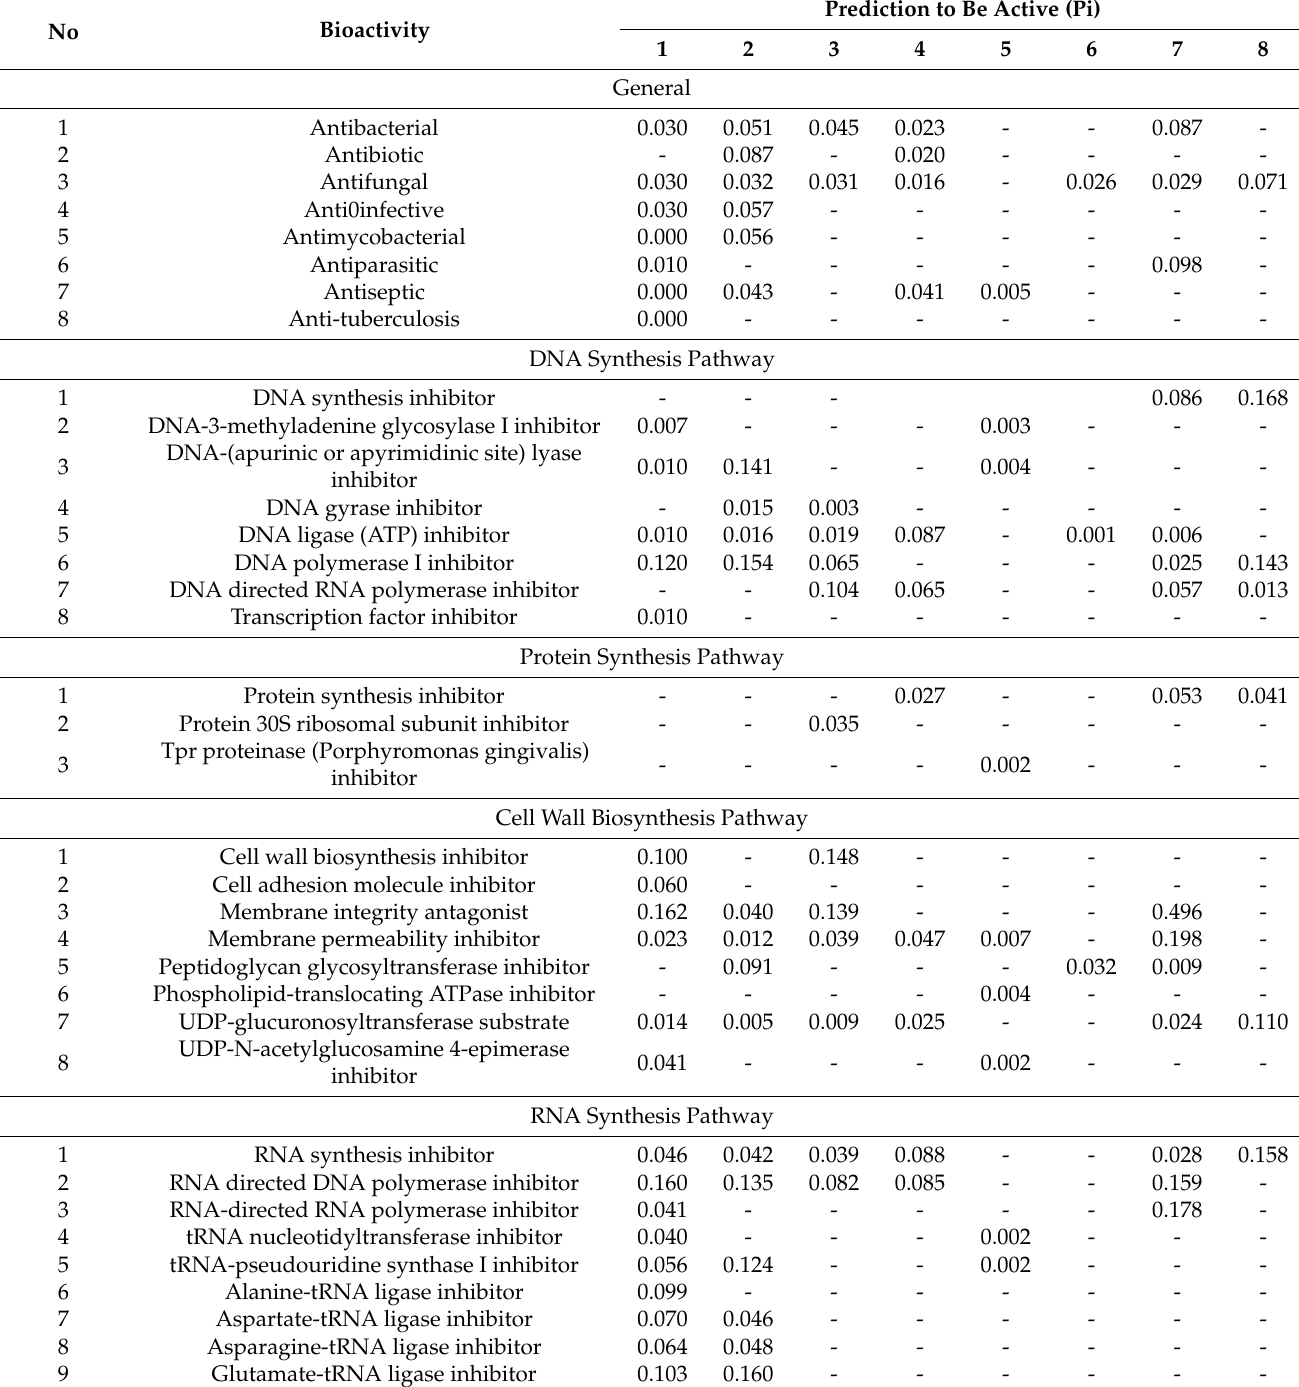
Table 2. Prediction inactivity of compound Bioactivity from PASS online